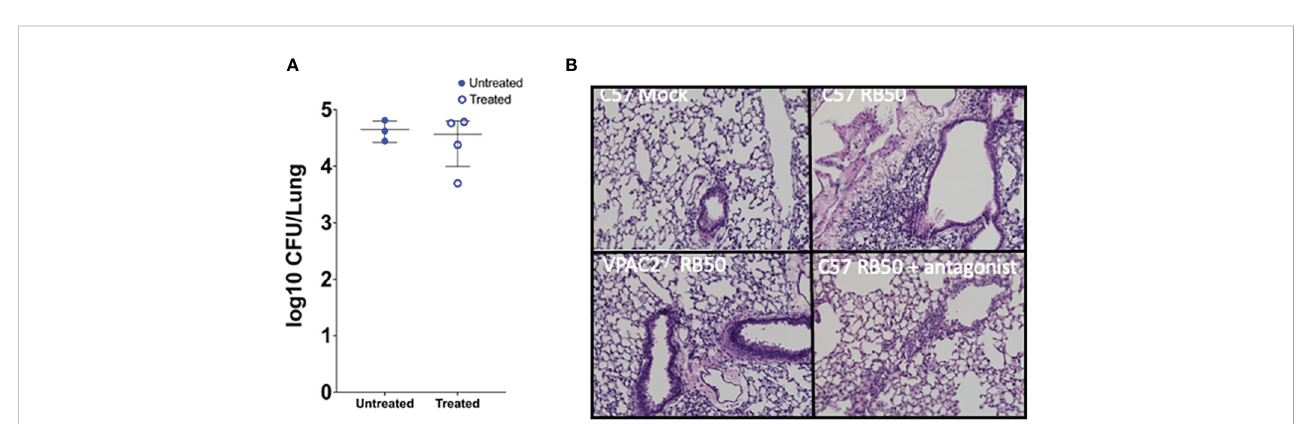
FIGURE 6 Treatment with VPAC2 antagonist reduce lung pathology. (A) C57BL/6J mice were intranasally challenged with B. bronchiseptica RB50. At day 1 post- infection, we started a treatment with the VPAC2 antagonist daily. Colonies were enumerated from the lungs at day 14, with solid blue points representing untreated mice, with the hollow blue points being the treated animals. Each point represents one mouse, with each bar representing mean ± SD ( A has an n=3-4 animals per condition, B has n=4-8 animals per condition). Two-way ANOVA analysis was performed to evaluate statistical differences. (B) H&E pathology staining was done at day 7 post-infection with a minimum of 4 animals per group. The above images are representative of each experimental condition.